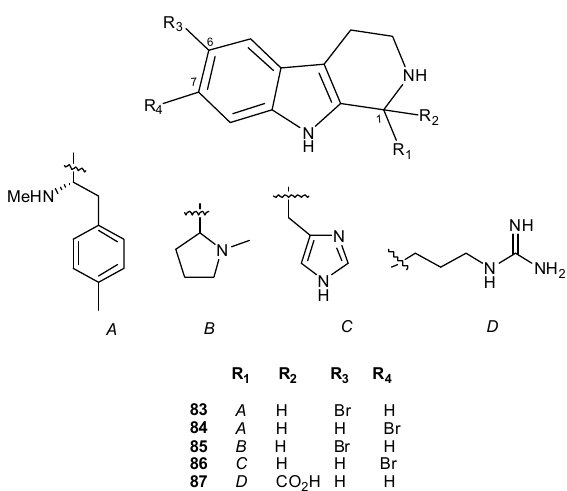
Figure 9. Tetrahydro-  -carbolines.